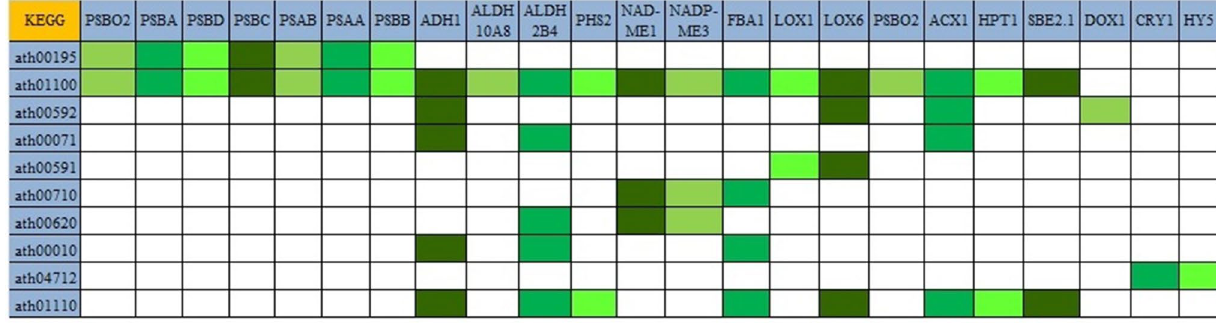
Figure 17. Kyoto Encyclopaedia of Genes and Genomes (KEGG) classification of top differentially expressed (up-regulated) genes. The genes were enlisted at the top and the colour pattern (green shades) indicates the involvement of a particular gene in a particular KEGG pathway.